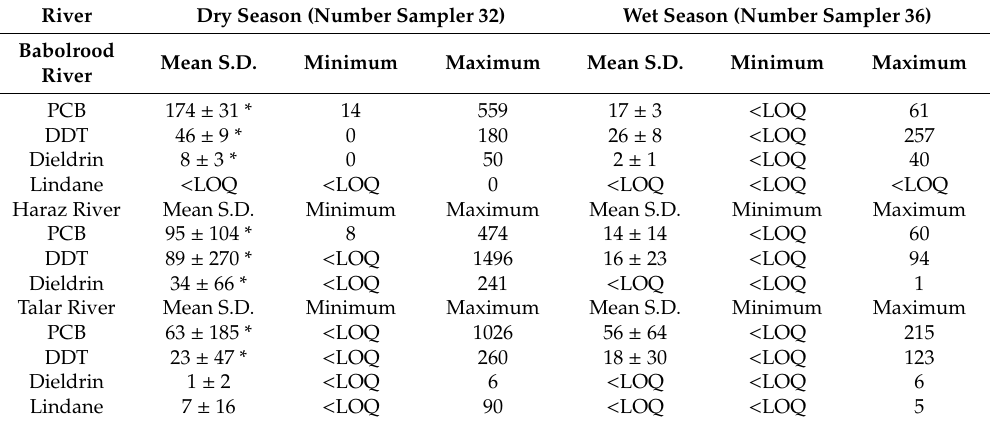
Table 4. Concentrations POPs of water samples in the dry and wet seasons in Babolrood, Talar and Haraz Rivers. * p <